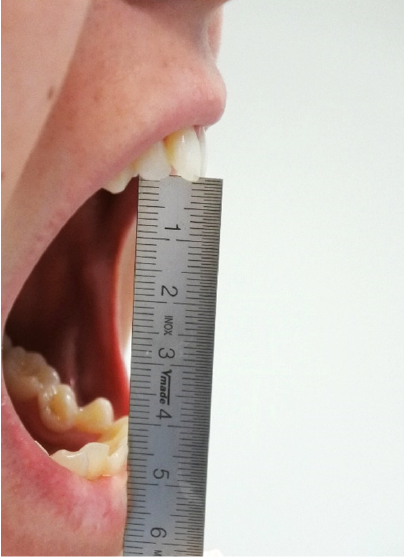
Figure 2. Measurement of the interincisal distance for trismus evaluation.